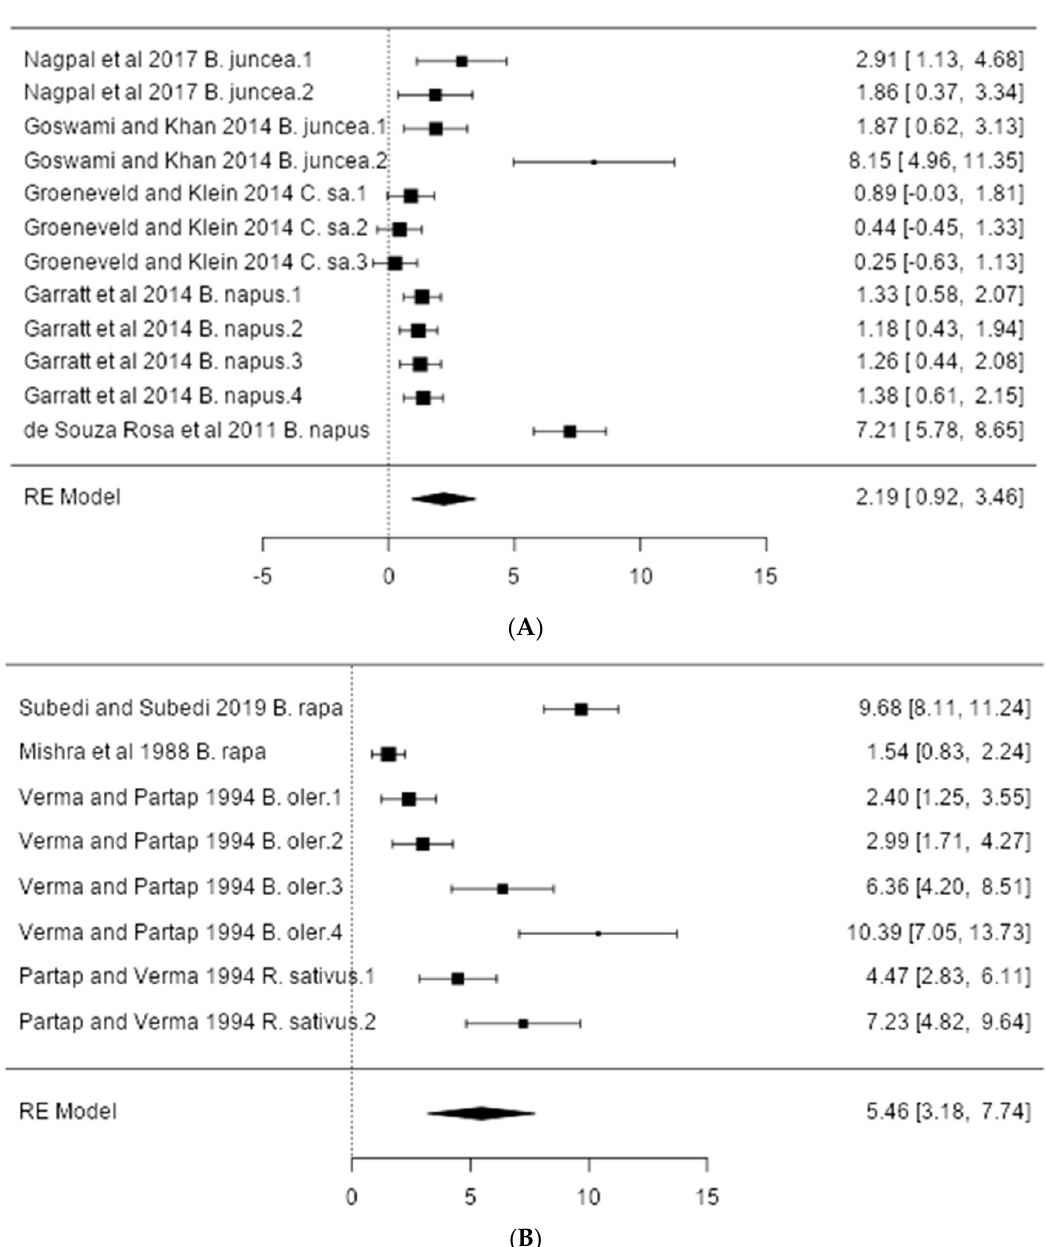
Figure 5. Forest plot of the meta-analysis for the effect of insect pollination on the silique set in self-compatible ( A ) and self-incompatible Brassicaceae crops ( B ). In the plots, B. oleracea and C. sativa are abbreviated to B. oler. and C. sa., respectively, to prevent overlapping with error bars and squares.